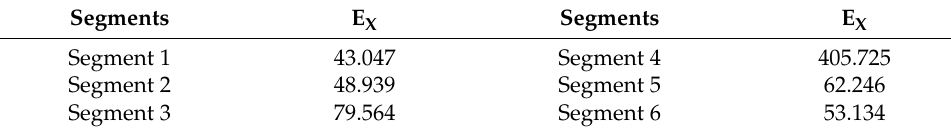
Table 4. Corresponding longitudinal dispersion coefficients for each segment (m 2 /s).